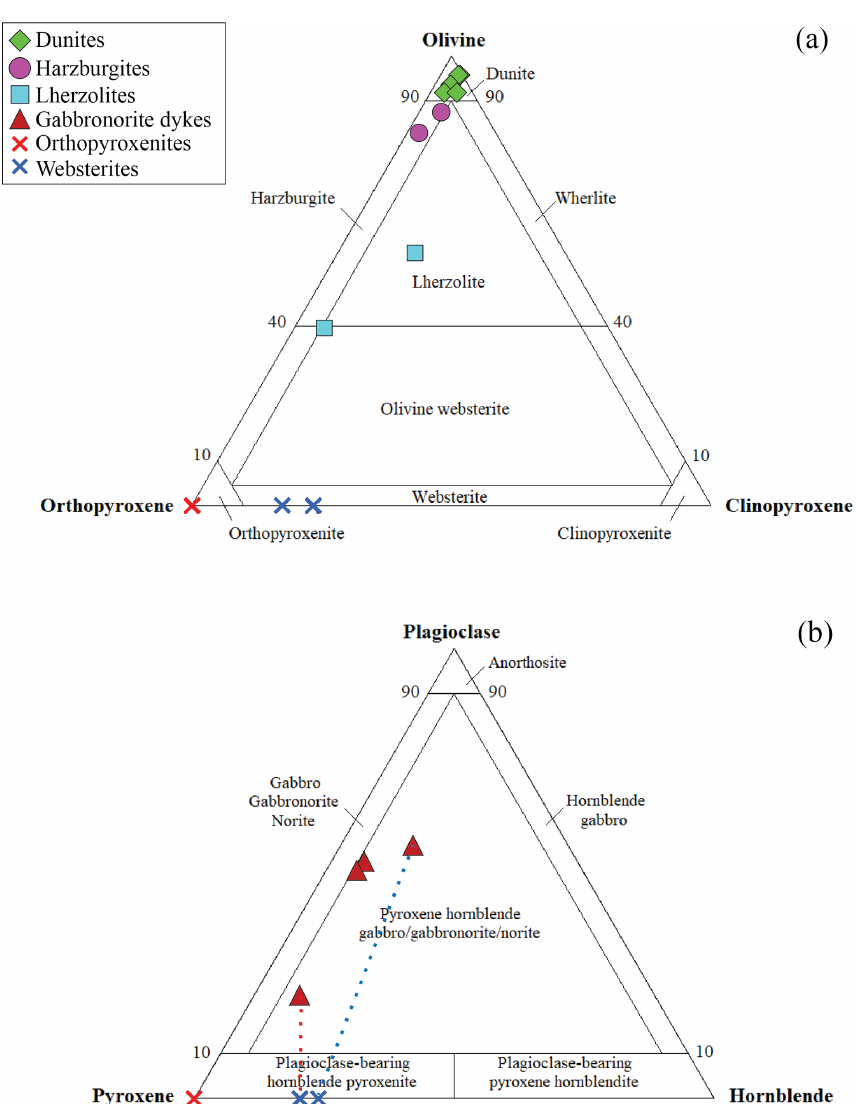
Figure 4. (a) Peridotite modal compositions (vol%) reported in the olivine–orthopyroxene–clinopyroxene classification diagram of ultra- mafic rocks. The compositions of orthopyroxenite and websterite micro-layers formed along the contacts between the peridotites and cross- cutting gabbronorite dykes are also reported. (b) Modal compositions of hornblende gabbronorite dykes (vol%) reported in the plagioclase- total pyroxene–amphibole classification diagram of gabbroic rocks. The compositions of orthopyroxenite and websterite micro-layers formed along the contacts between gabbronorite dykes and peridotites are also reported. The dotted tie lines refer to the gabbronites and physically adjacent websterite micro-layers (blue: sample BI2/5; red: sample